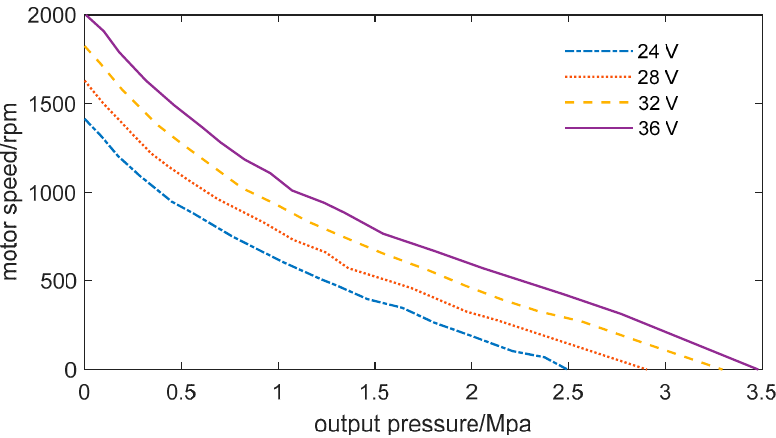
Figure 7. The variation of motor speed with outlet pressure.